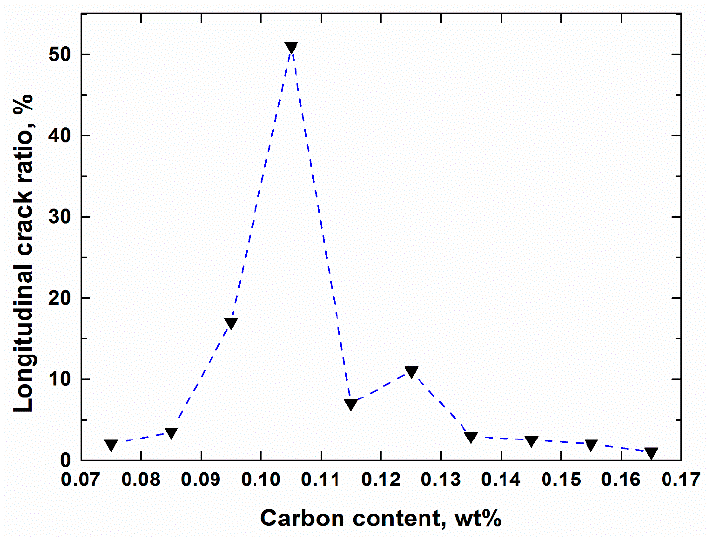
Figure 5. Longitudinal crack ratio in cast slabs.